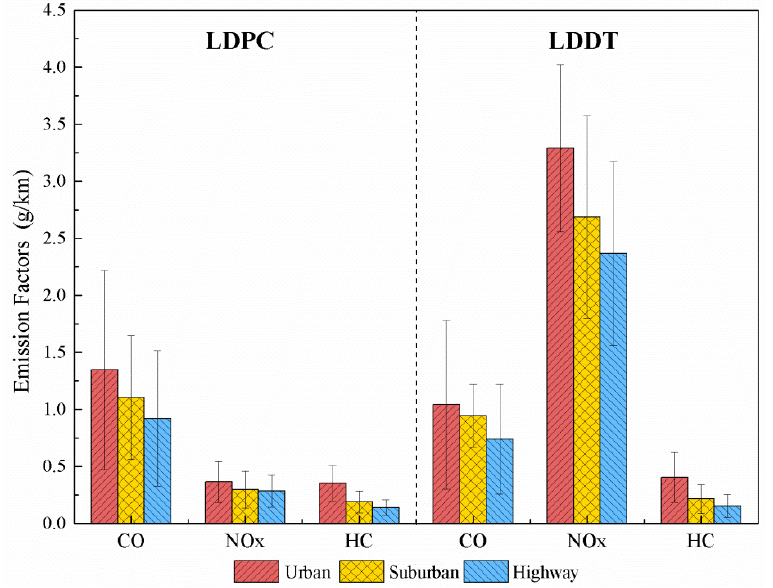
Figure 2. Average EFs of CO, NOx, HC under different road conditions (Error bars represent 1 standard error).